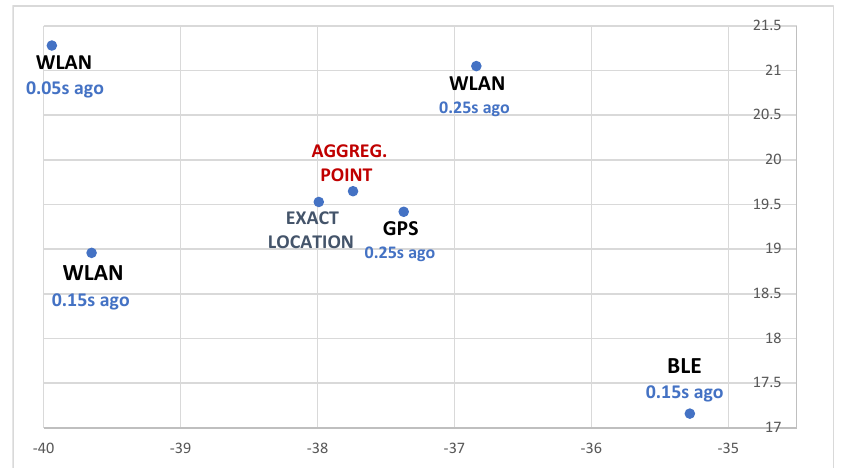
Figure 7. Visualization of data-aggregation method. On the first row are two measurements from the WLAN localization method. On the second row are localization data from the WLAN module (third measurement) and GPS. On the third row are data from a method based on BLE beacons and the localization-aggregation algorithm. Node is located at ( − 37.99,19.53 ) .